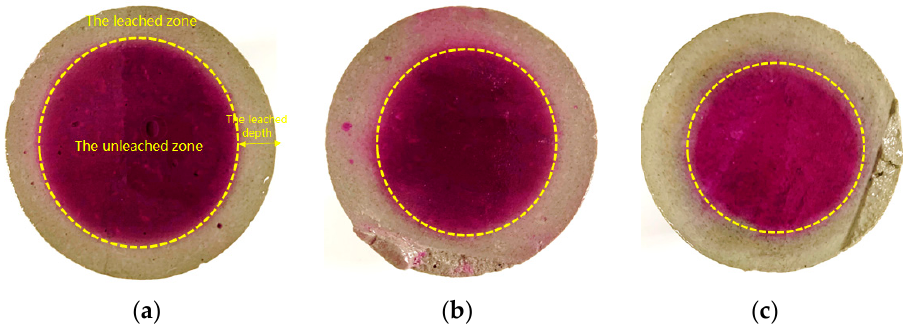
Figure 4. The leaching depth of the cement paste samples in the 35-day accelerated leaching test: ( a )PA0-045; ( b ) PA9-045; ( c ) PA9-050.